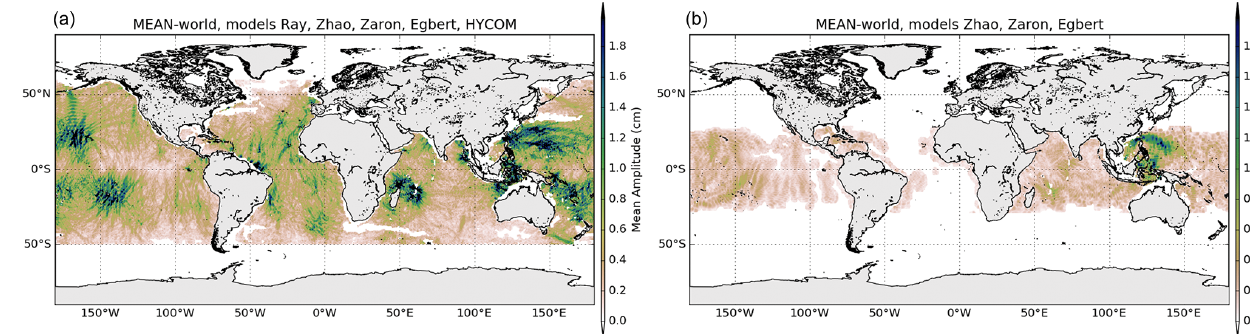
Figure 5. Global maps of mean amplitude of the M 2 (a) and K 1 (b) IT models (cm).